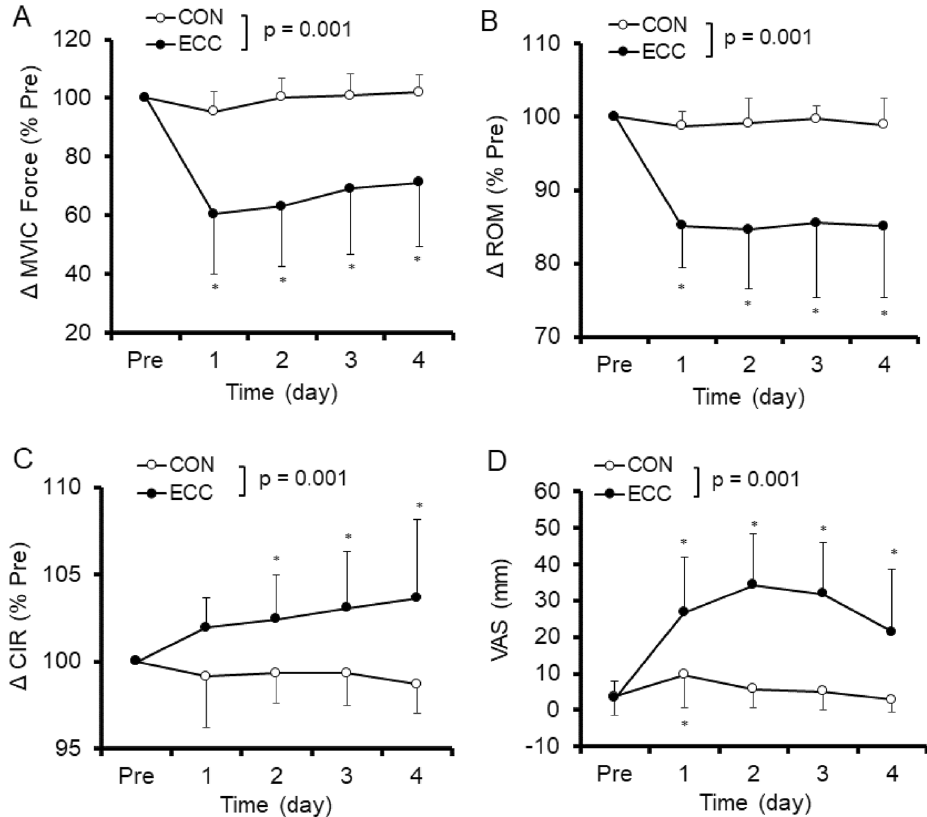
Figure 4. Normalized changes (mean ± SD) in maximal voluntary isometric contraction (MVIC) force ( A ), range of motion (ROM, B ), upper arm circumference (CIR, C ) and muscle soreness assessed by a 100-mm visual analogue scale (VAS, D ) before (Pre) and 1–4 day after exercise. A significant ( p < 0.001) interaction effect was found between eccentric (ECC) and concentric (CON) conditions for all variables. * shows significant ( p < 0.05) difference from the baseline